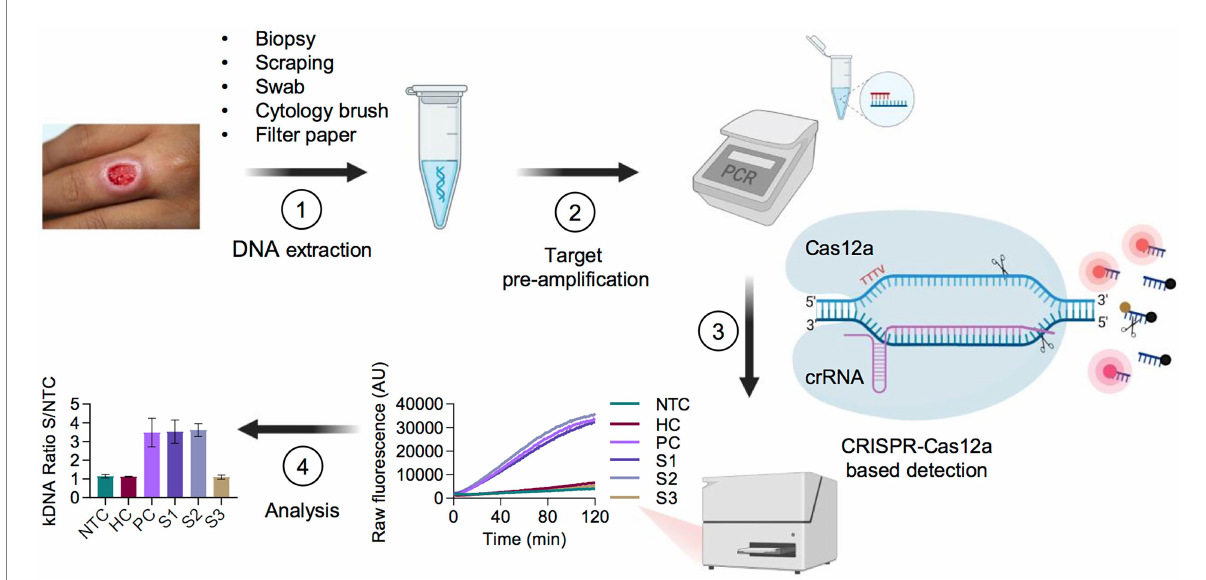
FIGURE 1 Schematic of the PCR coupled CRISPR-Cas12a-based assay workflow for detection of Leishmania spp. in clinical samples. (1) Skin lesion specimens suggestive of CL are processed for gDNA extraction. (2) The isolated DNA is subjected to PCR preamplification using primers targeting Leishmania kDNA minicircles or 18S rDNA, or the sample control, human RNase P gene. (3) The PCR amplicon is then used as input DNA for Cas12a-based detection guided by a target-specific CRISPR RNA (crRNA). A ternary complex is formed if the target DNA is present in the reaction mixture. Cas12a recognizes a 5 ′ -TTTV-3 ′ PAM in the target DNA, which results in base pairing between the crRNA guide (spacer) segment and the complementary target DNA. Upon specific target DNA recognition by Cas12a, the activated Cas12a enzyme generates non-sequence-specific cleavage of a single-stranded DNA (ssDNA) reporter probe, thereby producing a fluorescence signal that can be recorded by a fluorescence plate reader. (4) Normalized fluorescence readings (test sample/NTC), expressed as a fluorescence ratio, are used to interpret the assay results. As an illustrative example, data shown correspond to the kDNA target and are represented as mean ± standard deviation (SD; n = 2 independent amplification and detection runs). Standardized conditions consisted of ~ 90-min amplification (45 PCR cycles) and fluorescence signal (LbCas12a detection assay) at 20-min time point for kDNA and at 10-min time point for both 18S rDNA and RNase P. AU, arbitrary units; NTC, no-template control of the Cas12a reaction; HC, human PBMC gDNA from a healthy donor (negative control); PC, L. ( V. ) braziliensis M2904 gDNA (positive control); Samples S1–S3, DNA from clinical samples. Figure created with